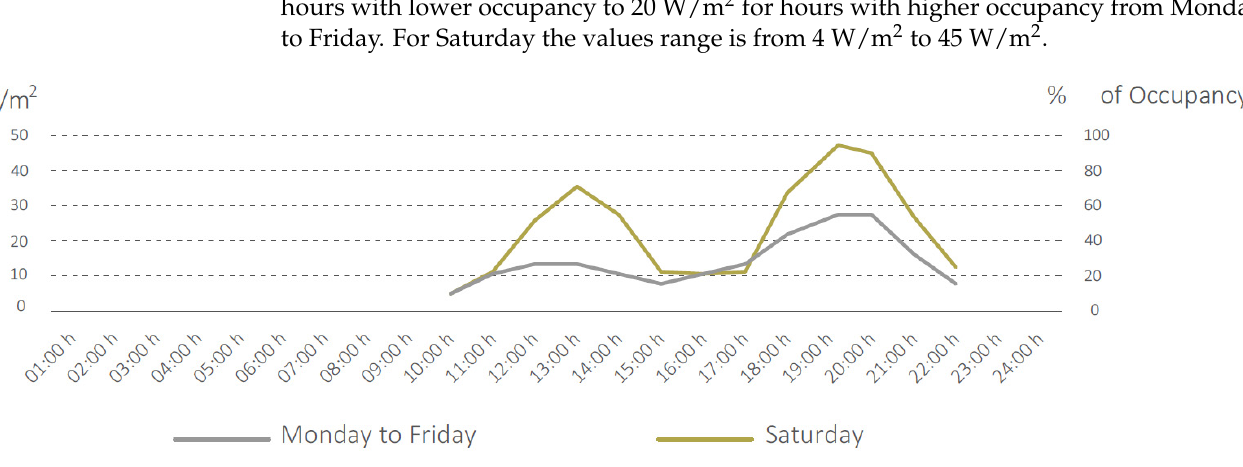
Table 6. Lighting power density according to the year of application.